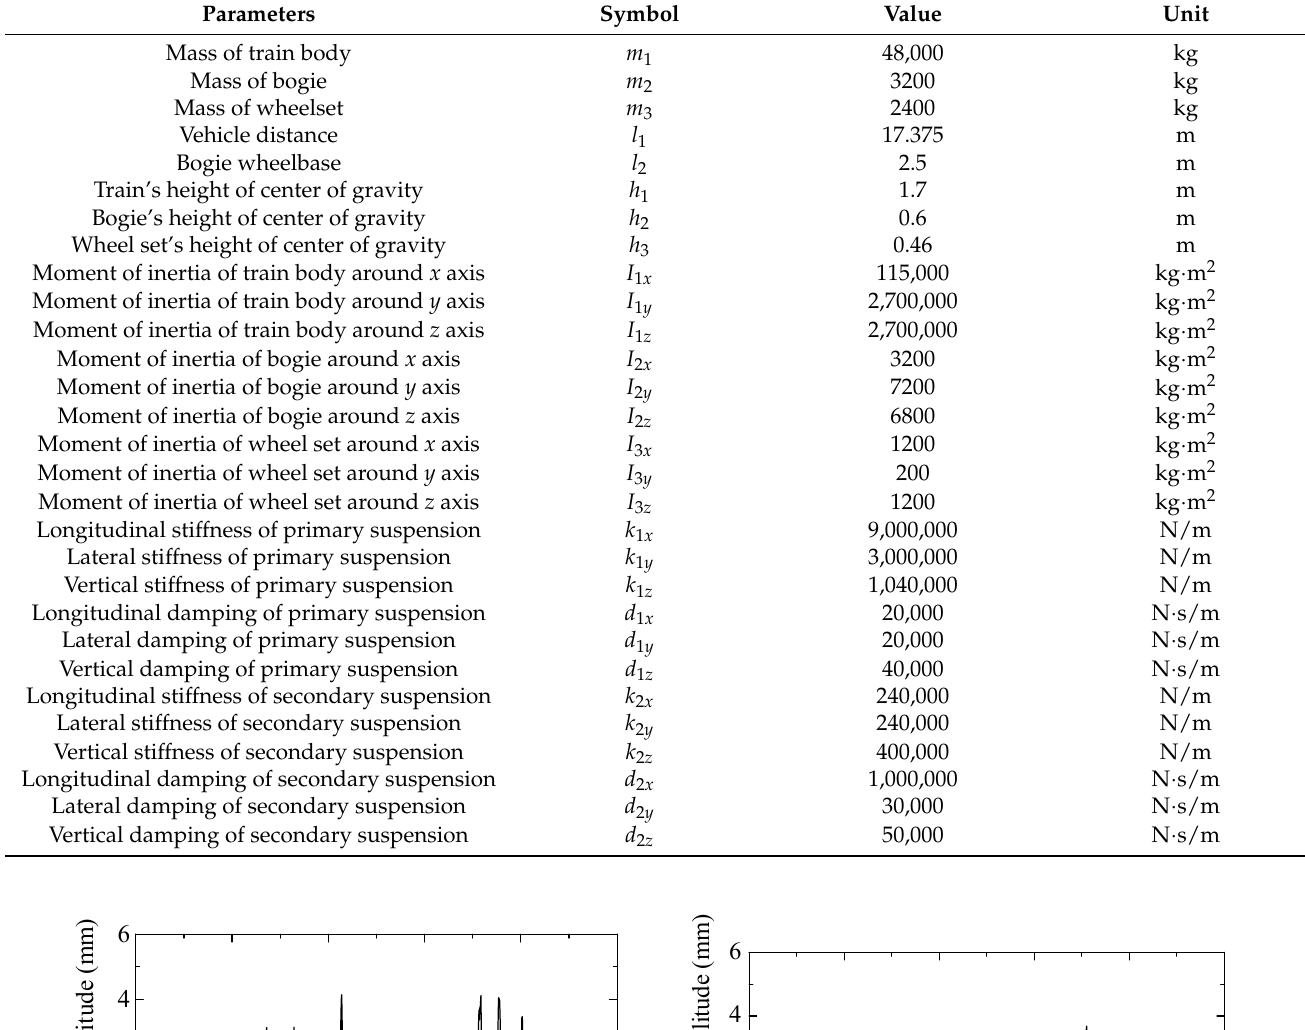
Table 6. Main parameters of CRH2.